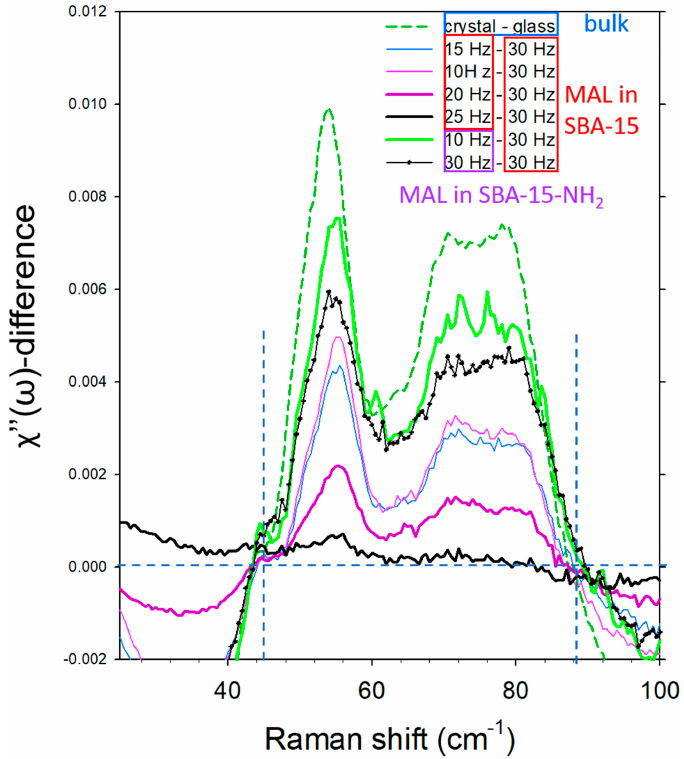
Figure A4. Spectrum difference in the representation of Raman susceptibility between composites prepared by MAL in SBA-15 and SBA-15-NH 2 at various milling frequencies and composites prepared by MAL in SBA-15 at 30 Hz. The crystallinity degree of IBP was calculated from the area limited by dashed lines .